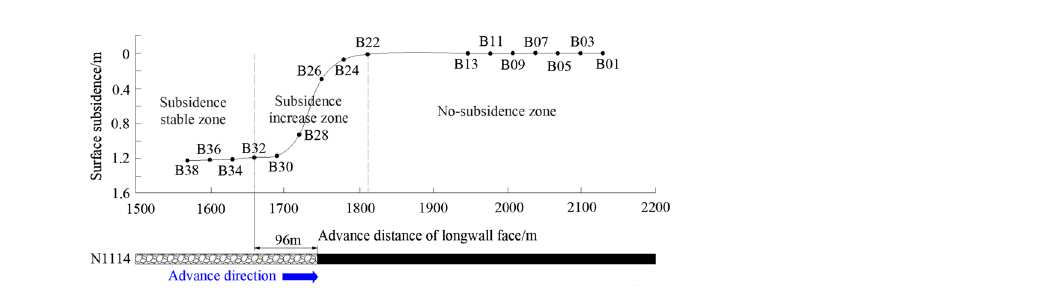
Figure 18. Surface subsidence by in-situ